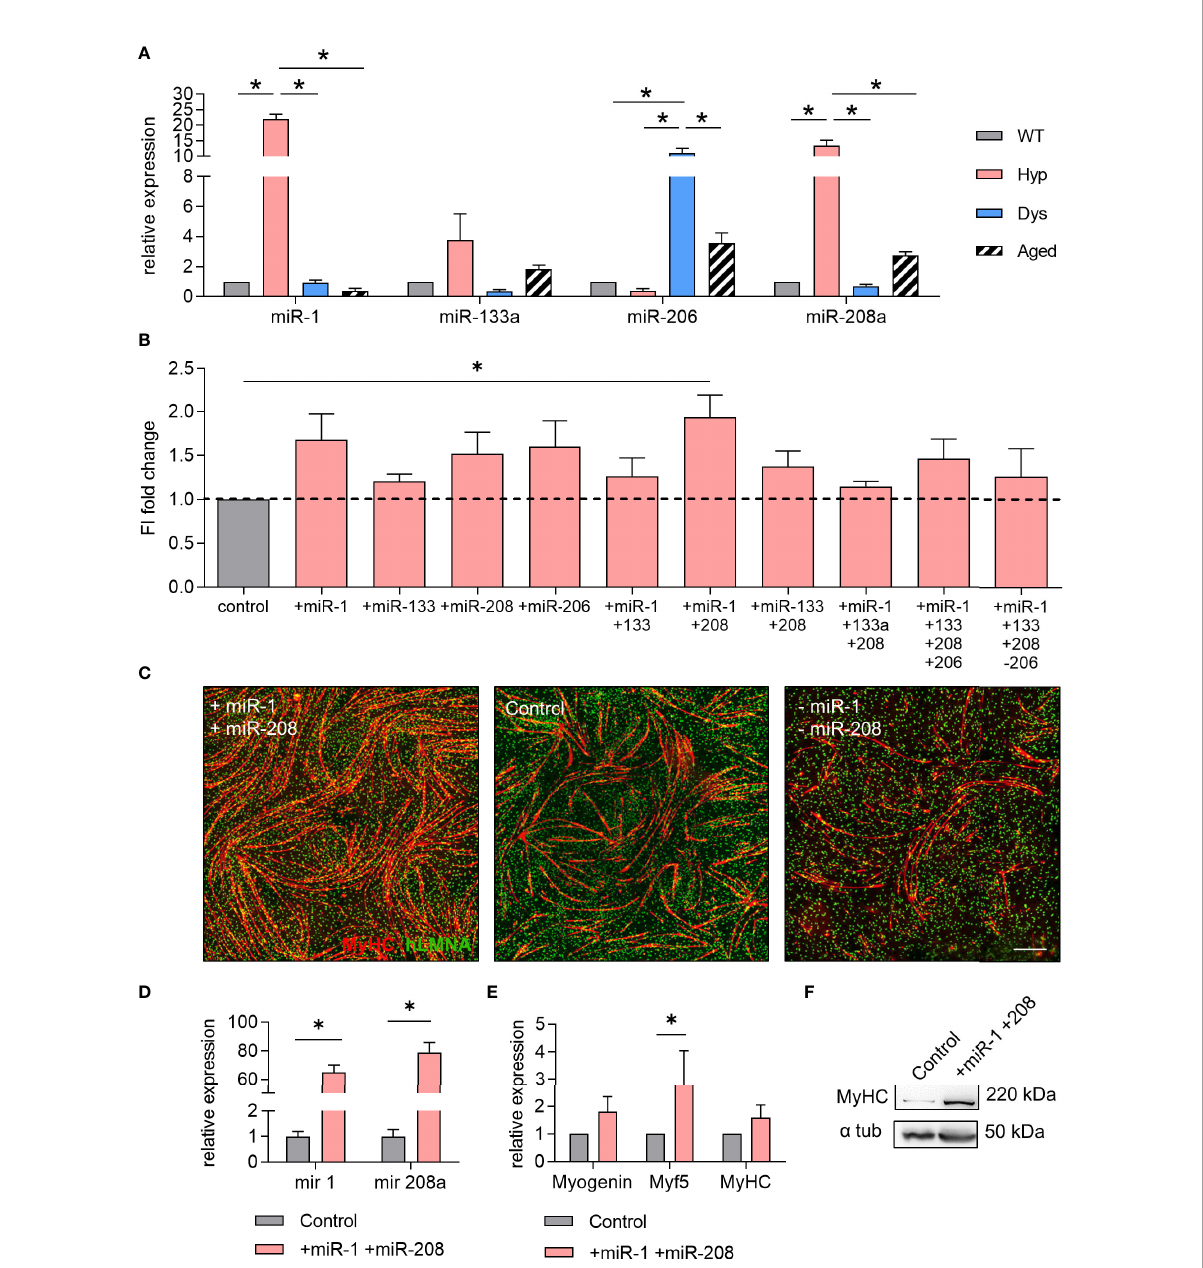
FIGURE 3 miR-1 and miR-208a increase the myogenic differentiation of human mesoangioblasts in vitro. (A) TaqMan qPCR analysis for the quanti fi cation of the selected microRNAs (miRNAs) miR-1, miR-133a, miR-206, and miR-208a in wild type (WT)-, hypertrophic (Hyp)-, dystrophic (Dys)-, and aged-derived extracellular vesicles (EVs). One-way ANOVA was used and results are displayed as mean±s.e.m (n = 5, *p < 0.05). (B) Fusion index of differentiated human mesoangioblasts (hMABs) treated with combinations of miRNA mimics and antagomirs for miR-1, miR-133a, miR- 206, and miR-208a (mimics are denoted by a + sign, antagomirs by a – sign). One-way ANOVA was used and results are displayed as mean±s.e.m (n = 4, *p < 0.05). (C) Representative images of immuno fl uorescence analysis for myosin heavy chain (MyHC) (red) and human lamin A/C (green) in differentiated hMABs after miRNA treatments with miRNA mimics and antagomirs for miR-1 and miR-208. Hoechst was counterstained in blue. Scale bars: 100 µm. (D – F) Differentiation of hMABs treated with miR-1 and miR-208 mimics resulted in higher levels of miR-1 and miR-208 (D) and an increase in mRNA expression (E) and protein level (F) of myogenic markers. Two-tailed Student ’ s t-test was used and results are displayed as mean±s.e.m (n = 5, *p <